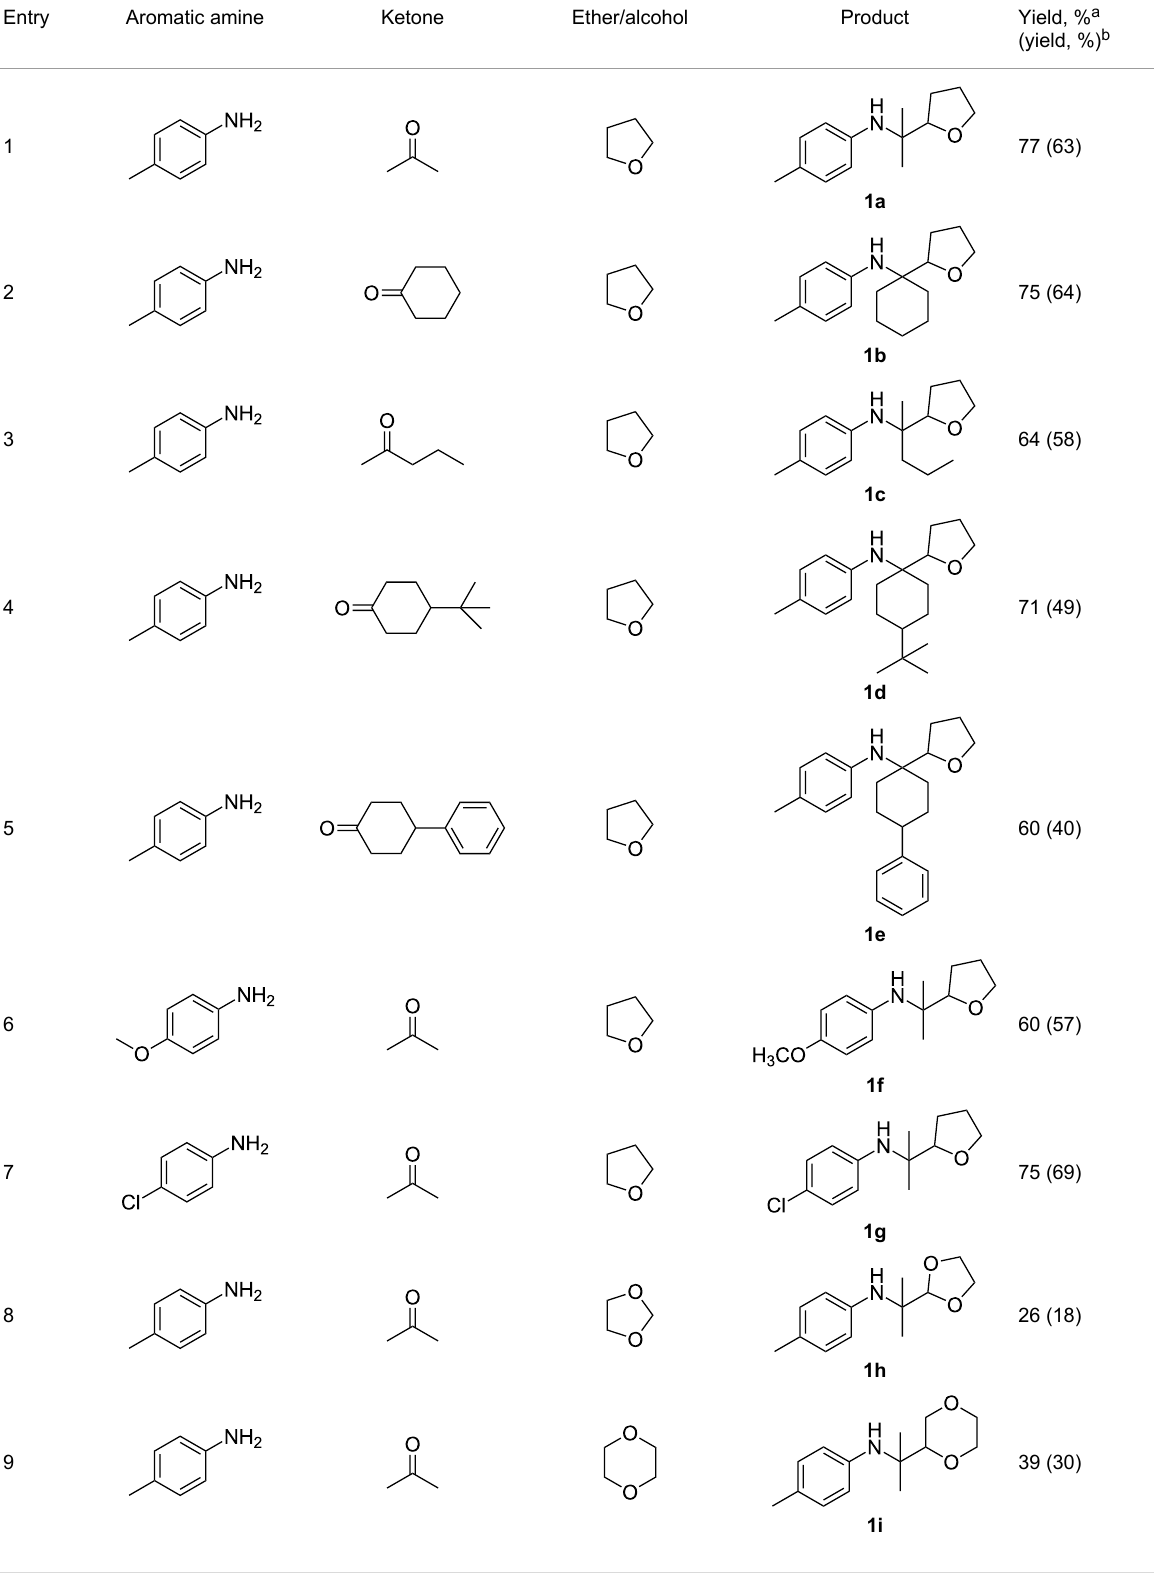
Table 2: Aminoalkylation of ethers and alcohols.